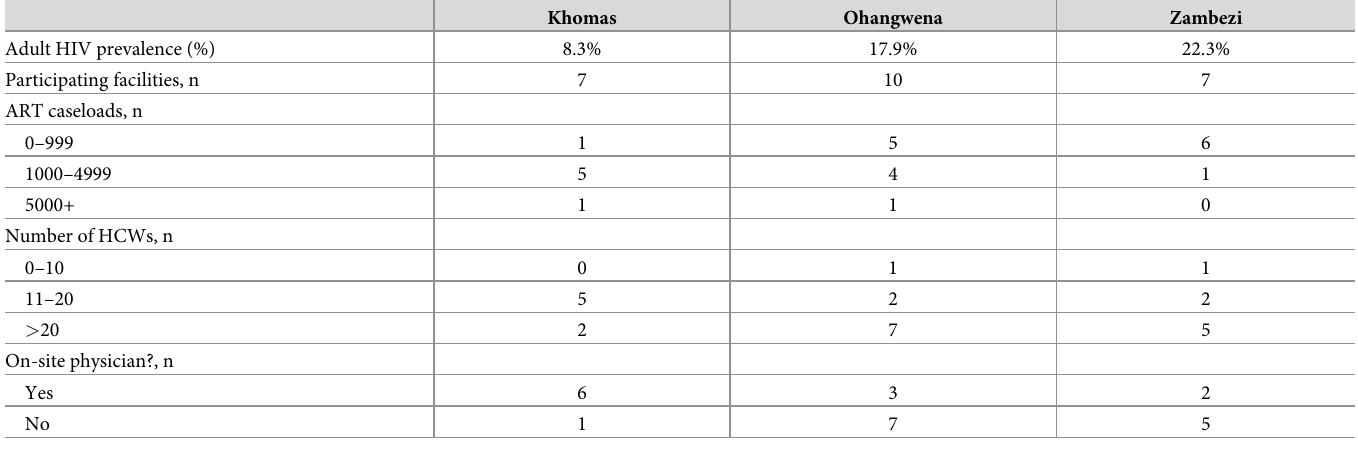
Table 1. Site characteristics, by